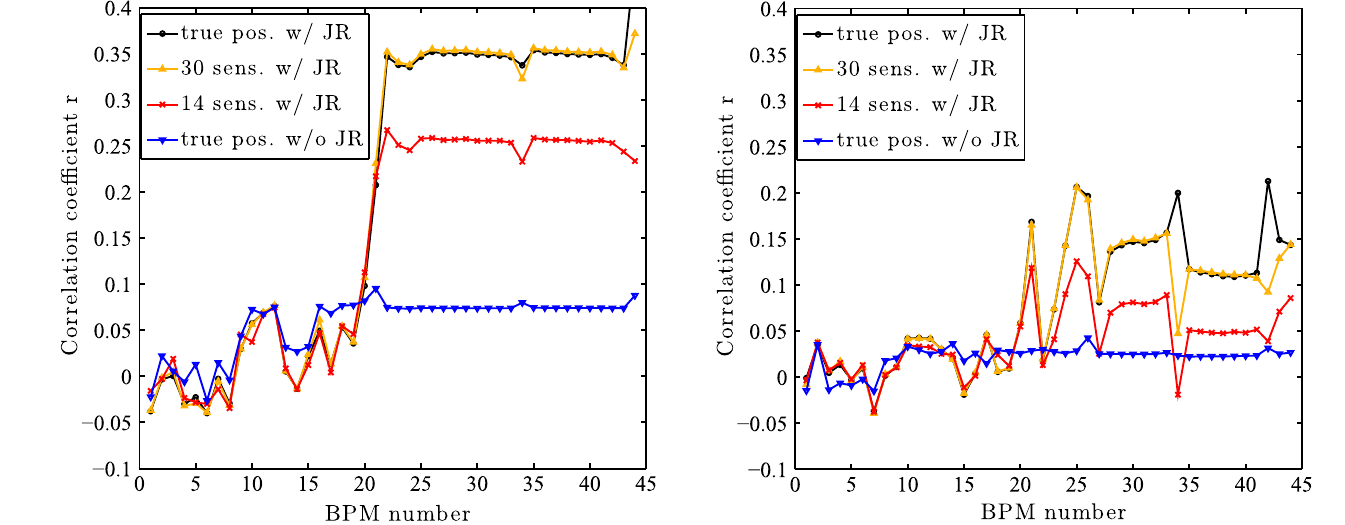
FIG. 6. Correlation coefficient r calculated from the BPM readings and the predicted ground motion effect for the vertical direction. For the prediction of the ground motion effect, either the true quadrupole positions have been used, or the positions are interpolated from the readings of 14 or 30 vibration sensors. Also the result with the orbit jitter after removal of the incoming orbit jitter (JR) is shown.